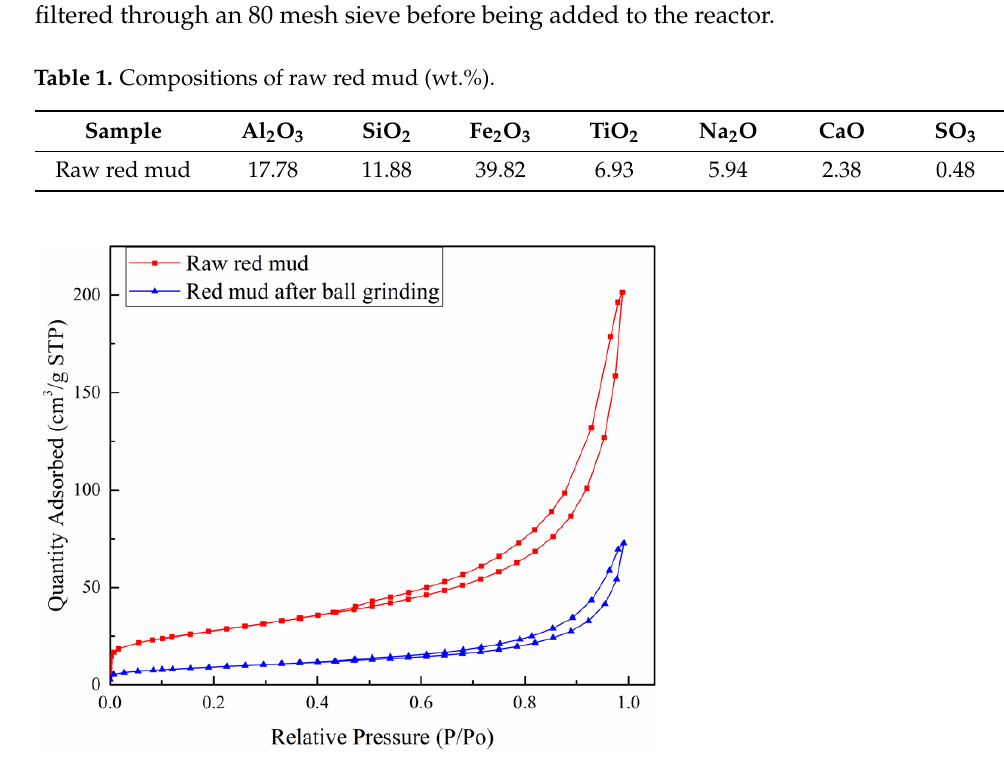
Figure 2. The two modes of action of the external field.